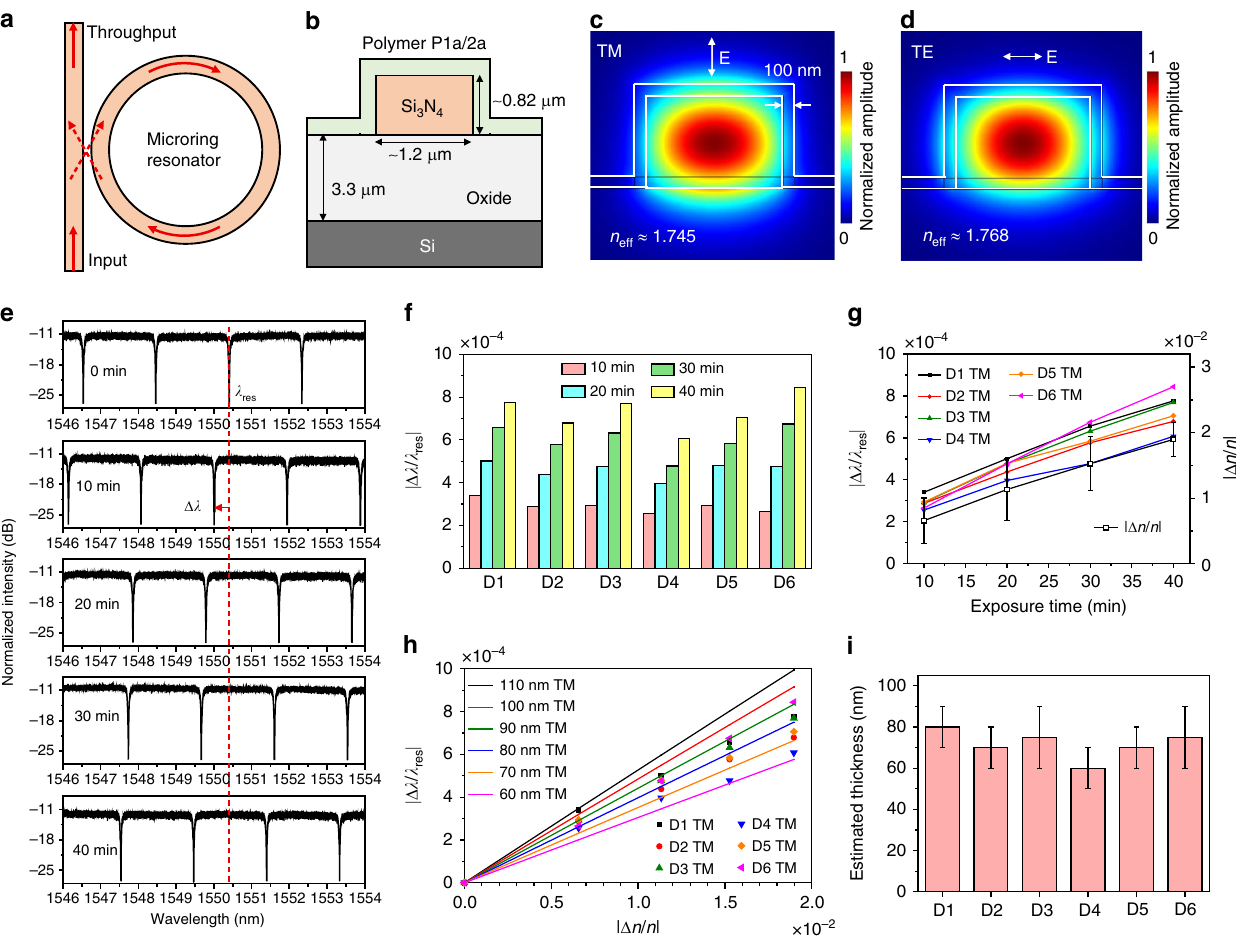
Fig. 7 Applications of photoresponsive polymer fi lms in integrated silicon photonics. a Schematic of a silicon-based microring resonator evanescently coupled with a bus waveguide. b Schematic of the cross section of a polymer-coated Si 3 N 4 waveguide. c , d FEM-simulated mode- fi eld amplitude distributions with c TM polarization and d TE polarization. e Measured transmission spectra of a microring near 1550 nm wavelength in TM polarization with UV exposure duration varying from 0 to 40 min at an interval of 10 min. f Extracted | Δ λ / λ res | of all the six measured devices in TM polarization. g Comparison between the extracted | Δ λ / λ res | of the microrings in TM polarization and the extracted | Δ n / n | of the polymer fi lms as a function of the UV exposure duration. The error bars indicate the standard deviations. h Comparison of | Δ λ / λ res | between the six measured devices and the simulations in TM polarization with the polymer thickness varying from 60 to 110 nm at an interval of 10 nm. i Estimated polymer thickness of the six devices based on both TM and TE polarizations. The upper and lower limits of the error bars indicate the estimated thickness values from TM and TE polarizations, respectively. The height of each colored bar is de fi ned as the average value of the upper and lower